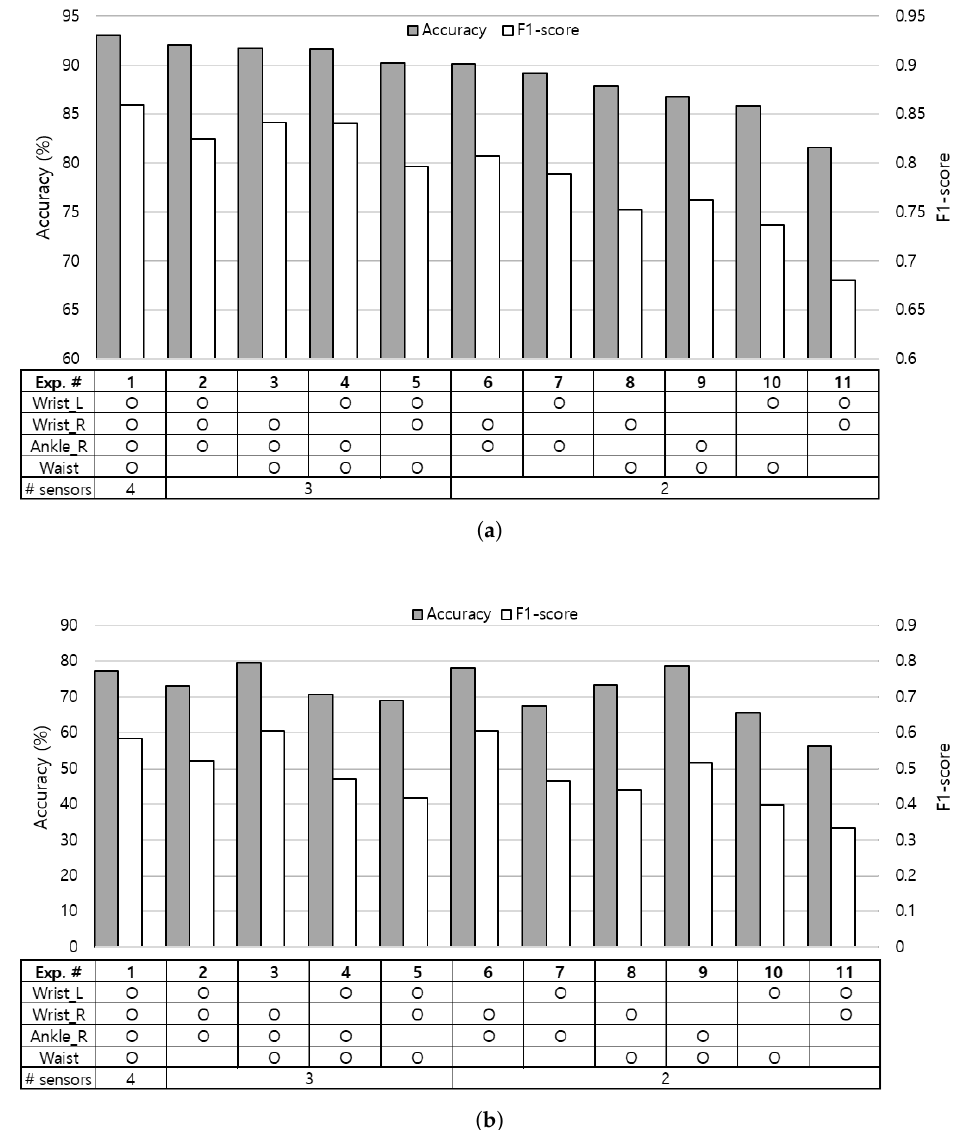
Figure 7. Recognition performance according to different numbers and combinations of body-worn sensors. Both accuracy and F1-score are adopted as the performance measure. ( a ) 10-fold cross-validation result; ( b ) Leave-one-subject-out cross-validation